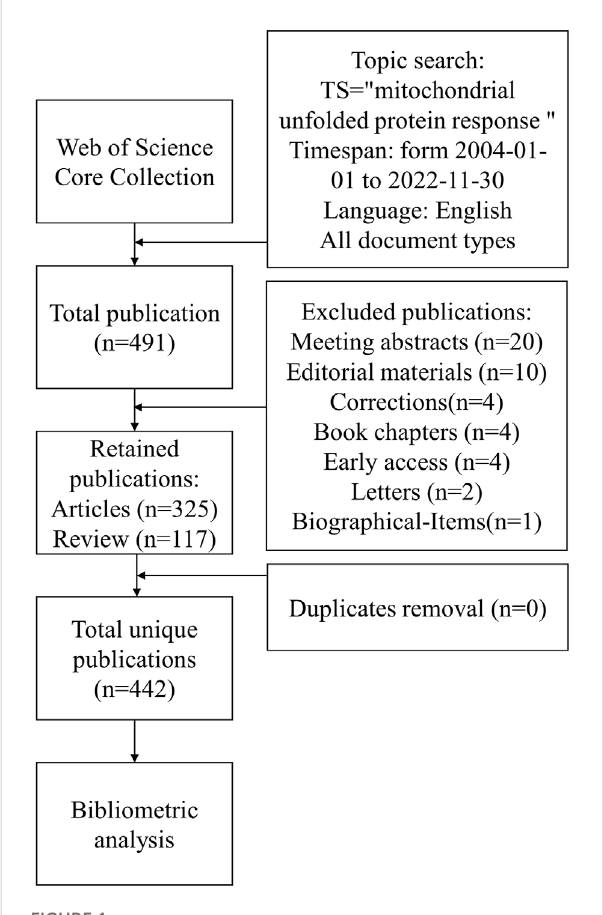
The fl owchart illustrating the search formula and selection process in this